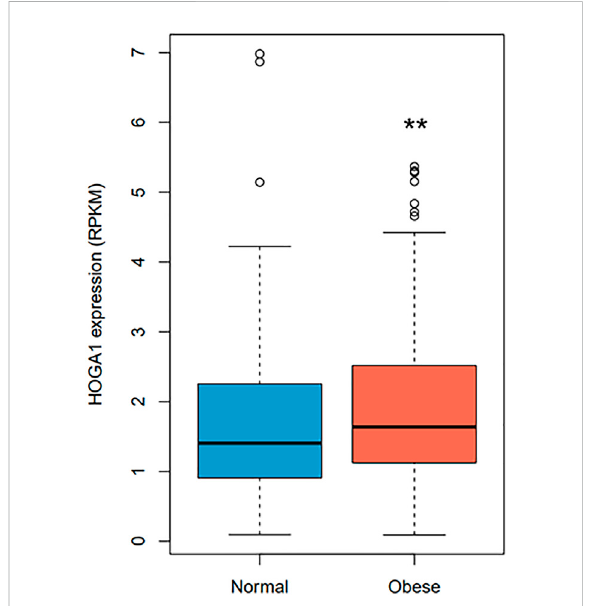
FIGURE 2 HOGA1 expression levels in adipocytes detected from the GTEx dataset. HOGA1 expression was compared between normal and obese individuals using RNA sequencing data of adipocyte